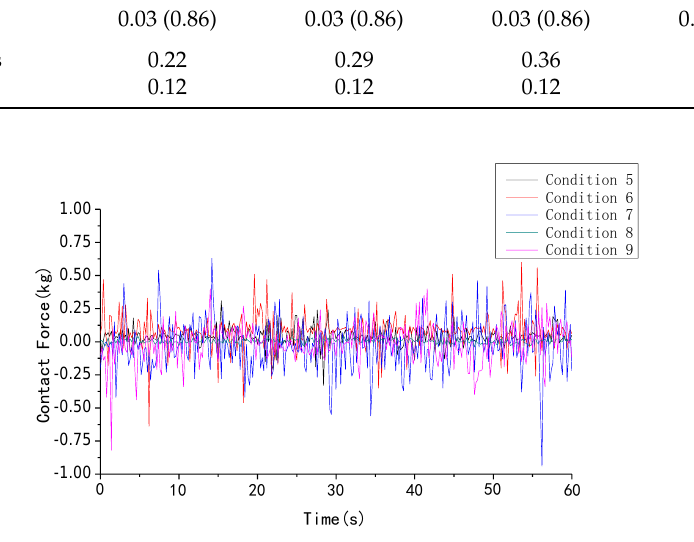
Figure 8. The curve of contact force vs. time considering towing speed effect.